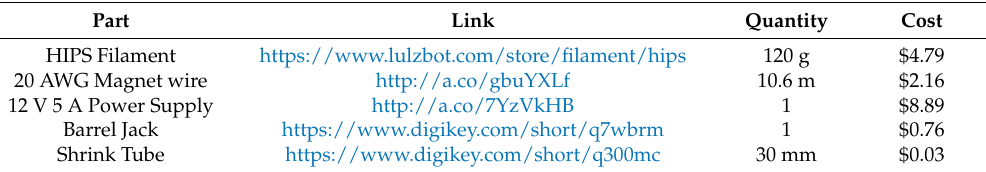
Table 1. Bill of materials for the 30 slide—open-source slide dryer.